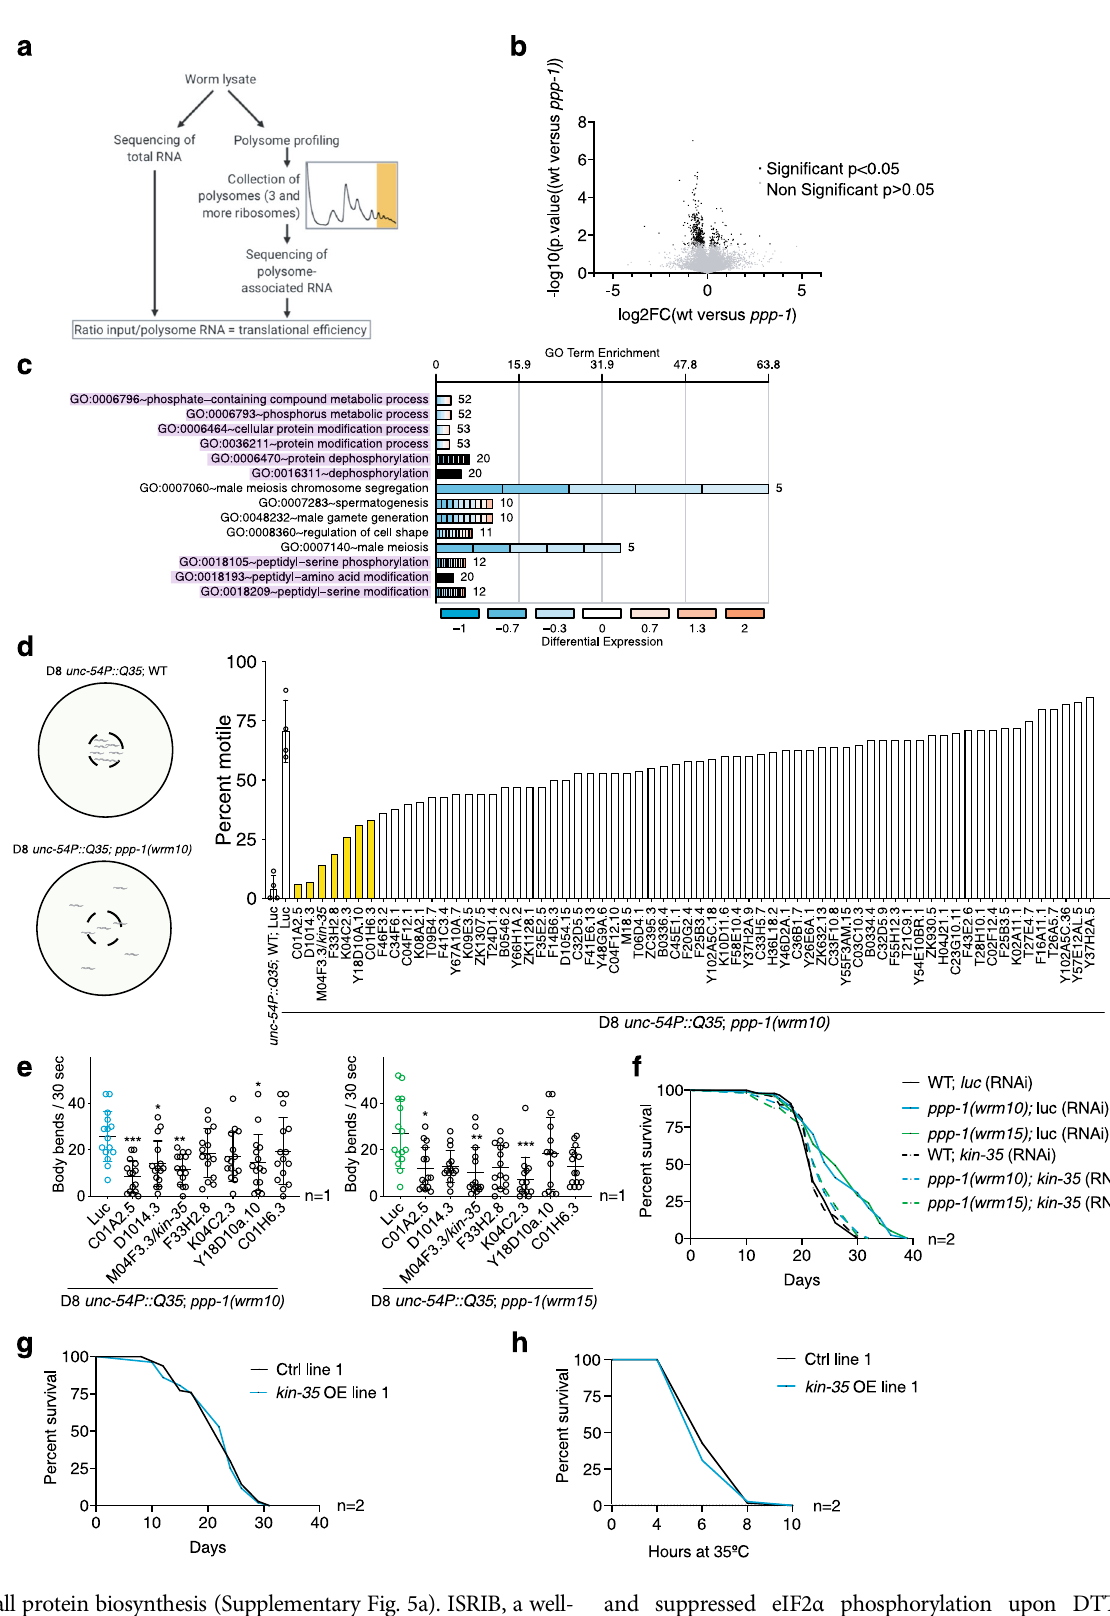
and suppressed eIF2 α phosphorylation upon DTT treatment (Fig. 5c). Surprisingly, estradiol valerate treatment initiated at day 5 or day 10 of adulthood equally increased survival (Fig. 5b) sug- gesting that late ISR inhibition might be suf fi cient to promote lifespan extension. Other estradiol derivatives do not interfere with the ISR 34 , suggesting speci fi city. In agreement with the